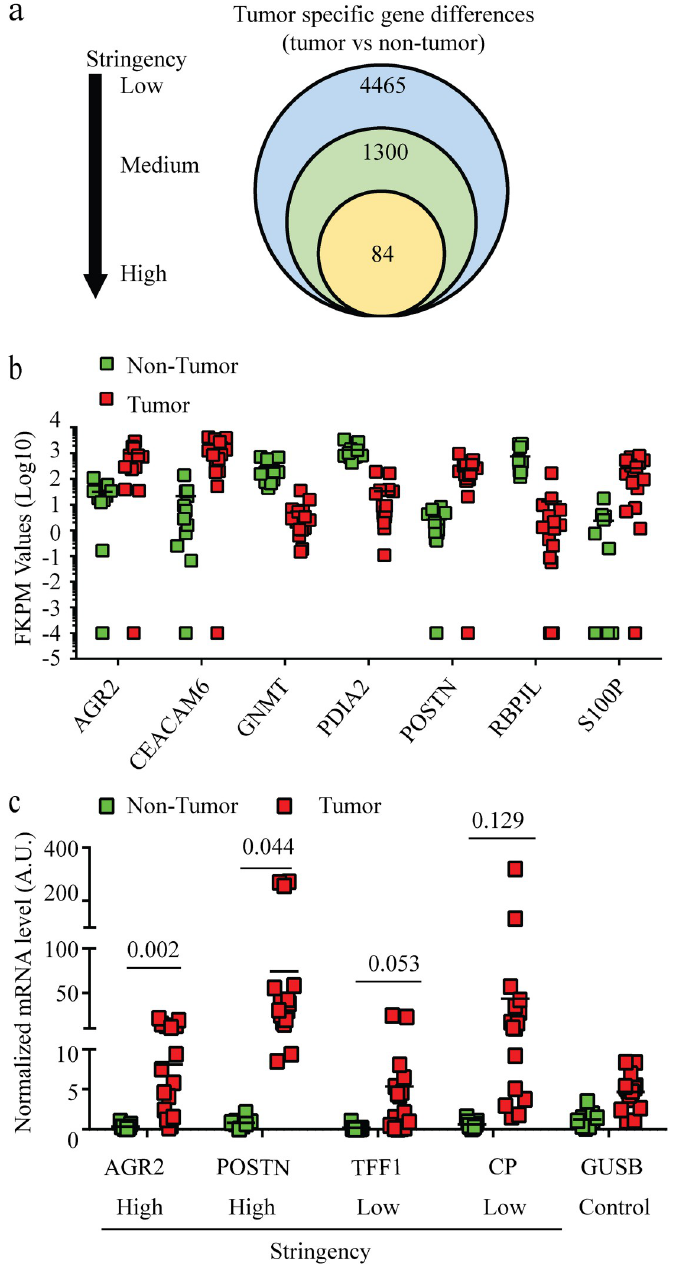
Fig 1. Characterization of human pancreatic tumor tissue transcriptome as compared to the non-tumor tissue transcriptome. (a) Venn diagram of the number of significant gene differences that meet the low, medium, and high stringency criteria form the dataset. (b) High stringency identified genes that were statistically different (nominal p < 0.05) between tumor and non-tumor pancreatic tissue using a two-tailed ANOVA with tissue type and gene as factors. (c) mRNA levels of AGR2 , POSTN , TFF1 , CP and PMM1 using RT-PCR. PMM1 was used as a control. The p values from each Student T test are provided for each gene and the mean values are presented as